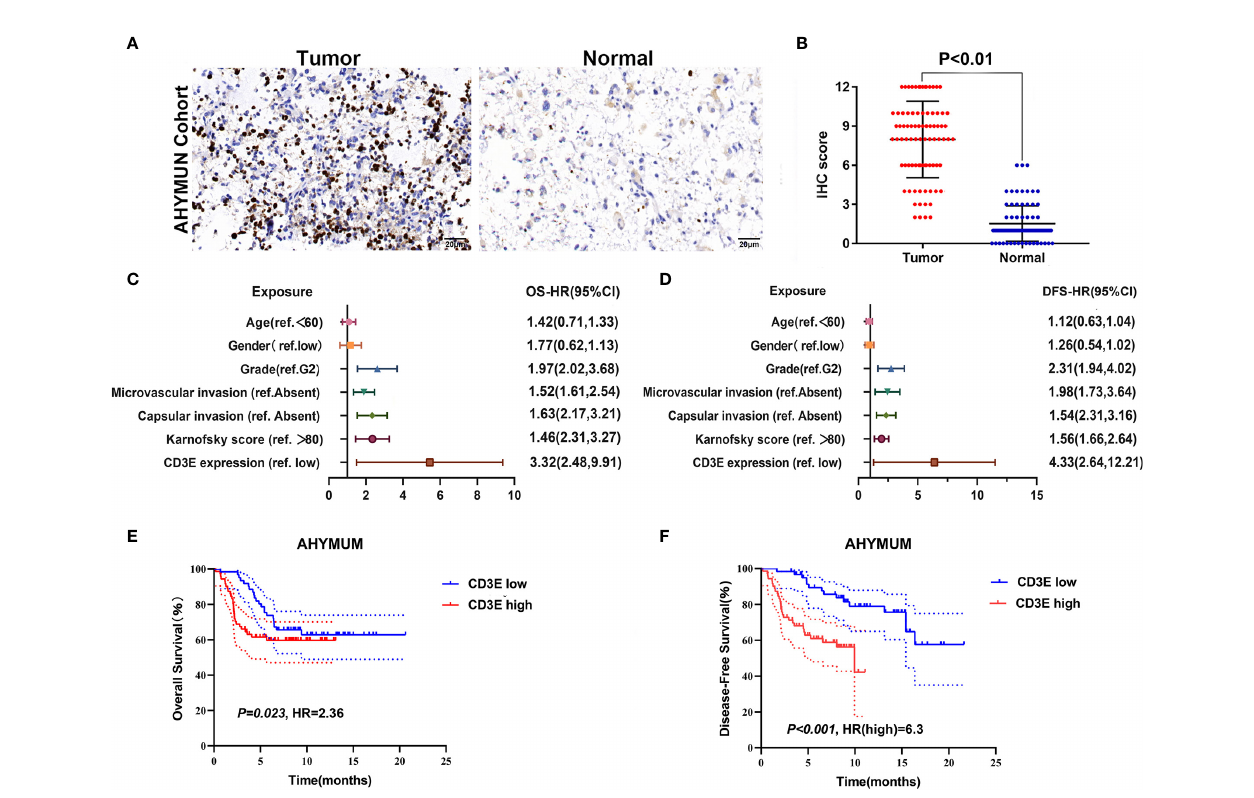
FIGURE 12 | The relationship between CD3E gene and LGG prognosis was further veri fi ed. (A) IHC on collected LGG tissue. (B) The scatter plot of the IHC scores ( P < 0.01). (C, D) Forest plots were used to visualize the univariate Cox regression analysis of OS and DFS in the AHYMUM cohorts. (E, F) Survival curves showed that LGG patients with elevated CD3E expression levels in the AHYMUN cohort showed poorer OS ( P = 0.023) and poorer DFS ( P <